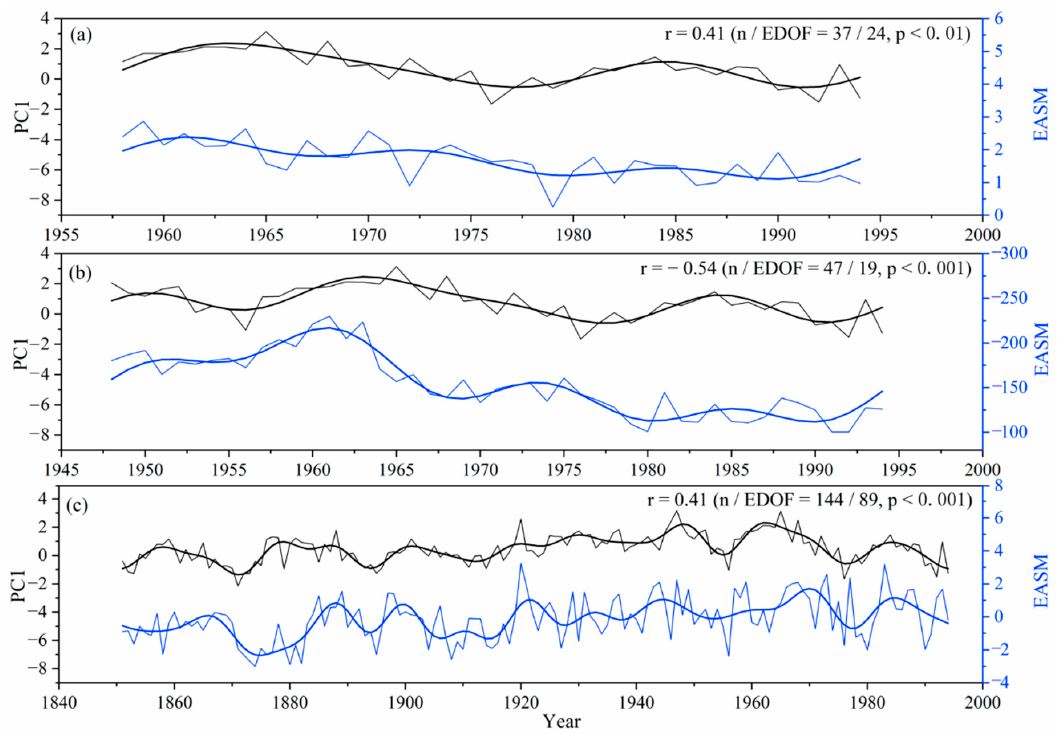
Figure 7. Comparison between the PC1 series and EASM indices defined by ( a ) Lau [33], ( b ) Guo [32], and ( c ) Wang [31]. The thick lines are 10-year low-pass filter series.